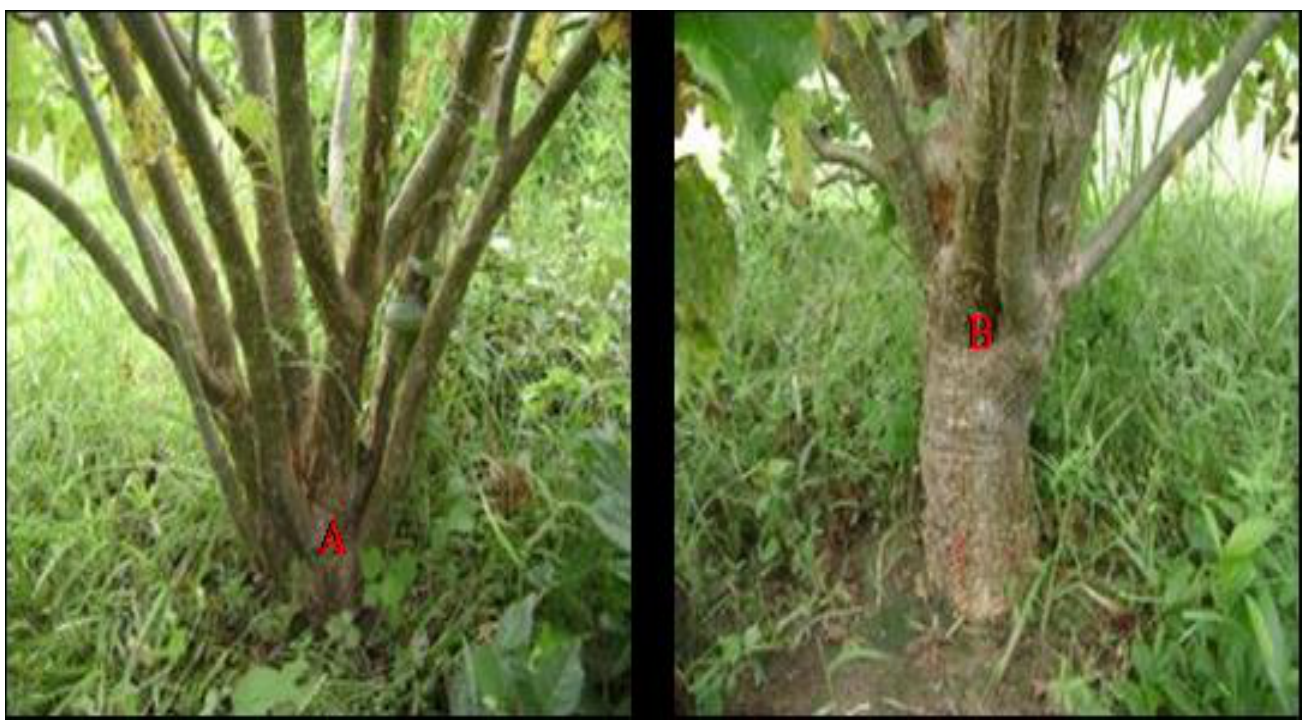
Highlights in BioScience Page 4 of